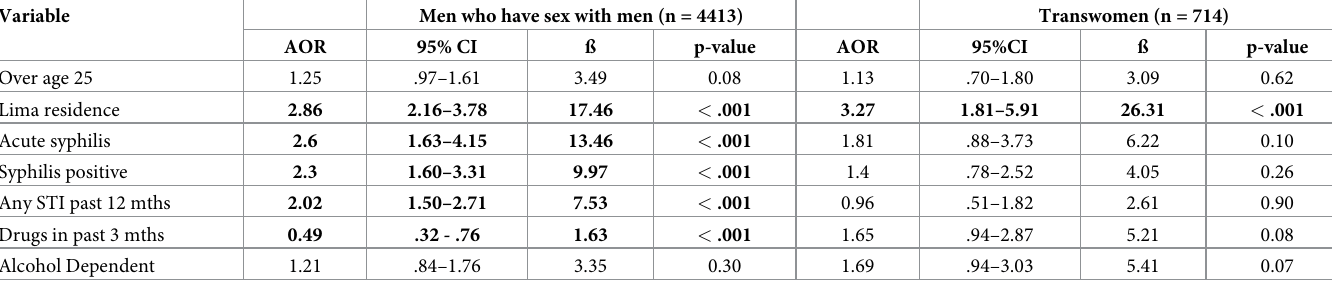
Table 2. Specific independent risk factor differences for HIV among transwomen and men who have sex with men (N = 5,127). Variable